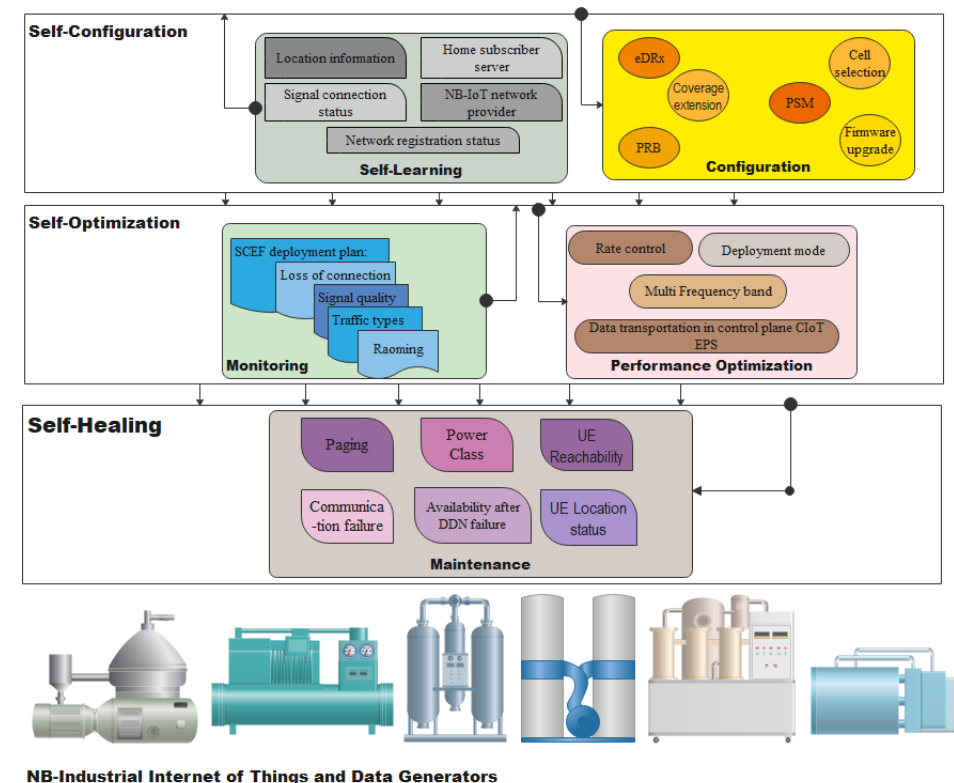
Figure 14. Application of SON in NB-IoT